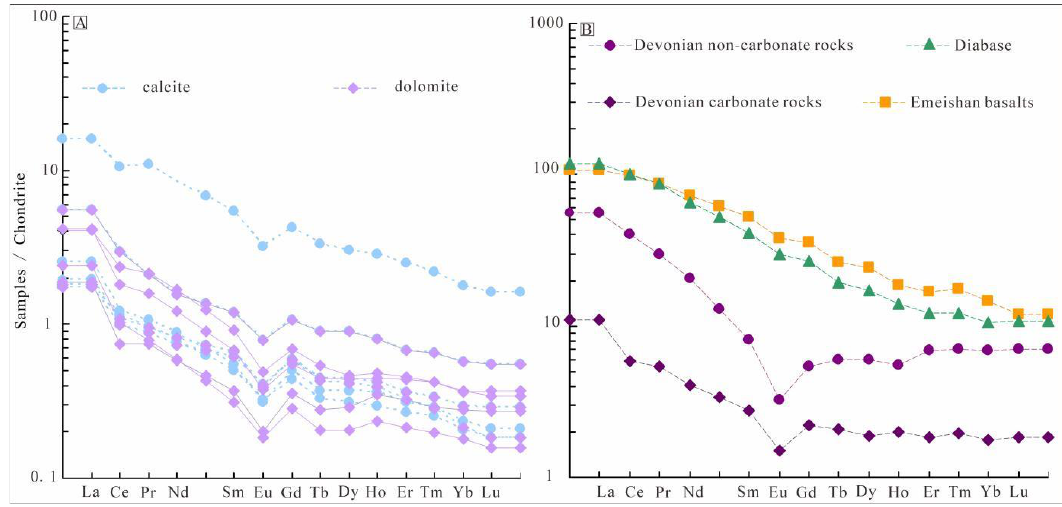
Figure 7. ( A ) The rare earth elements distribution of calcite and dolomite in Lekai Pb-Zn deposits; ( B ) The rare earth elements distribution of carbonate rocks and non-carbonate rocks in Devonian, Emeishan basalts, and Diabase in SYG Pb-Zn metallogenic province